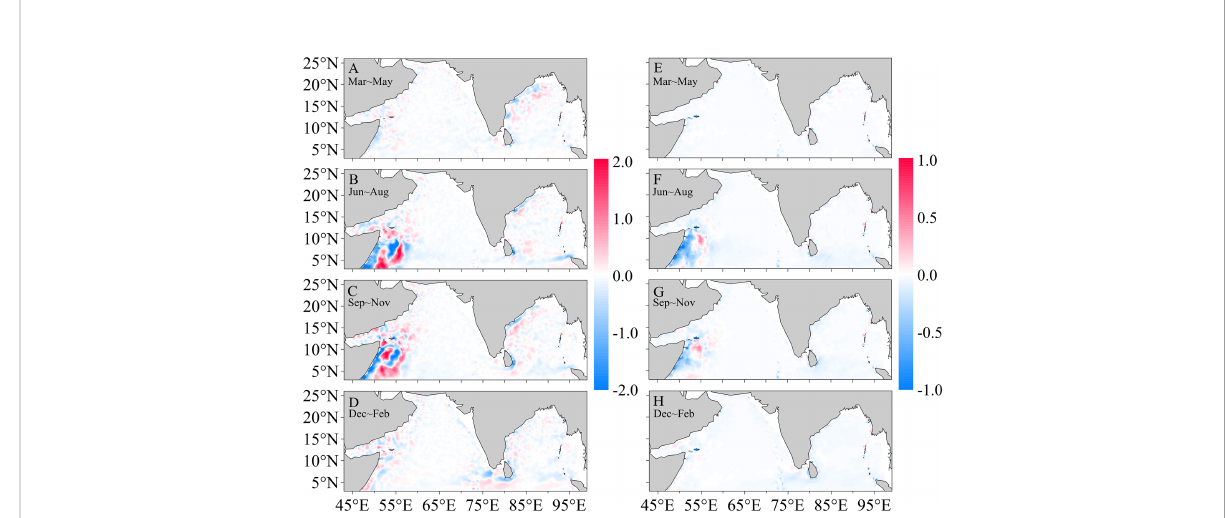
FIGURE 9 Seasonal distribution of horizontal eddy kinetic energy (EKE) redistribution (A-D) and vertical EKE redistribution (E-H) averaged from the surface to 200 m in spring, summer, autumn, and winter (unit: 10 -7 m 2 ·s -3 ).